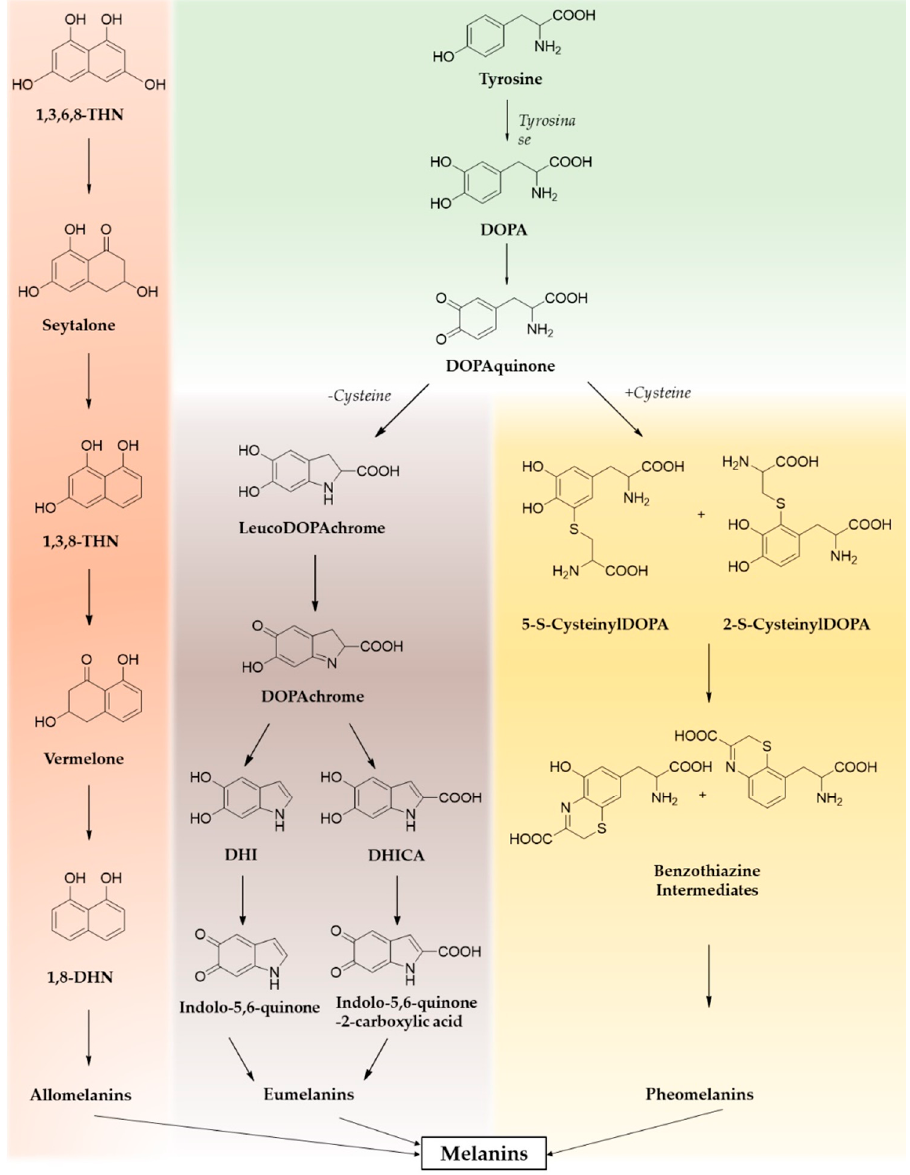
Figure 1. Melanins’ biosynthetic pathways.